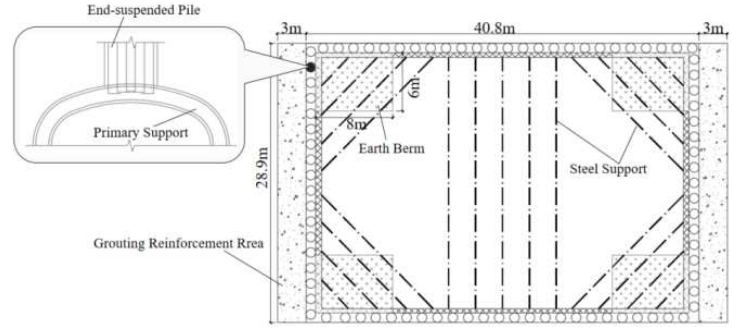
Figure 15. Schematic diagram of safety reinforcement